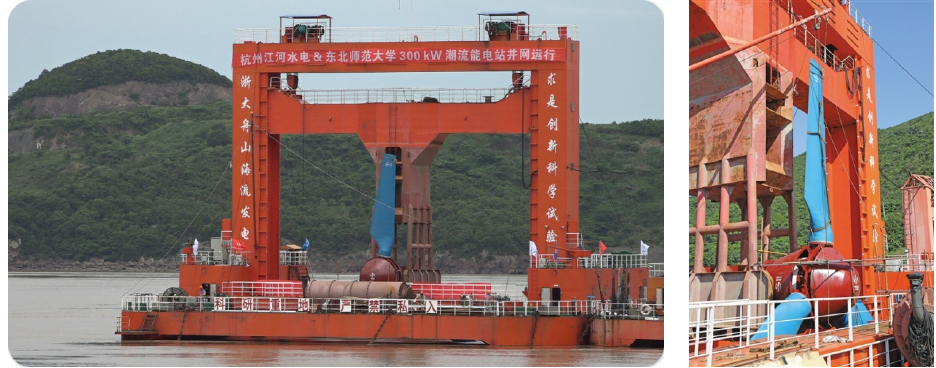
Figure 14. A 300 kW horizontal-axis self-variable-pitch TPCGS. Reproduced from [36,38].